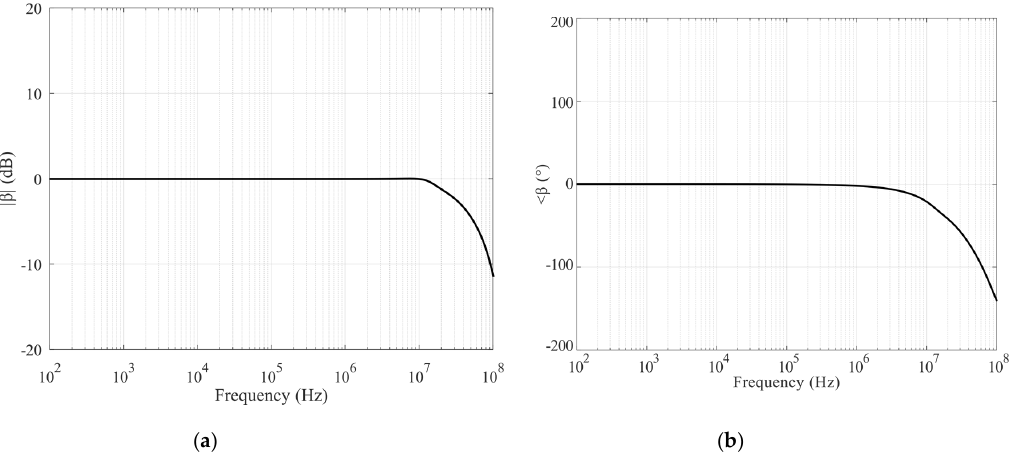
Figure 6. Voltage bu ff er characteristics: magnitude ( a ) and phase ( b ) of β